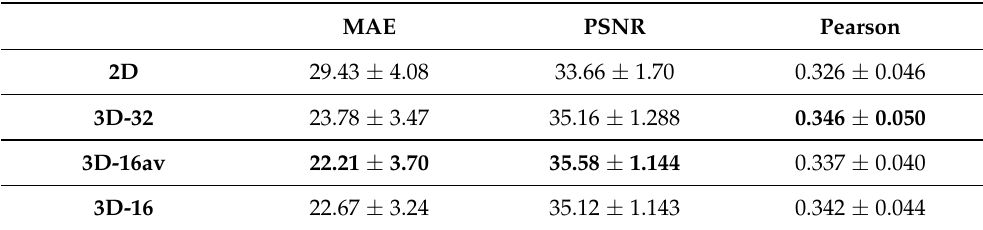
Table 10. Head dataset Soft-tissue with U-net. Mean Absolute Error, PSNR and Pearson coefficient within the soft-tissue on the head data set obtained using U-net with different convolutions and reconstructions.